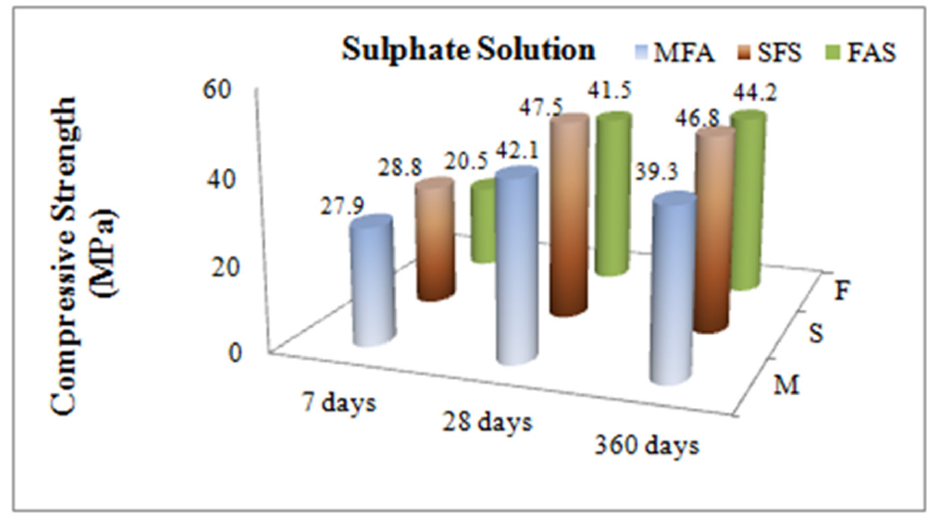
Figure 6. Effects of mineral admixtures on compressive strength of concrete for day 7, 28 and 360 exposed to sulphate solution.